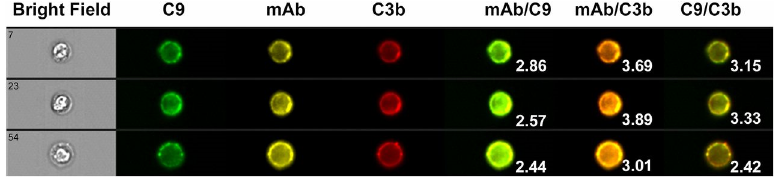
Figure 12. C3b and C9 are colocalized on B cells opsonized with mAb 7D8-Hx. C3b and C9 are colocalized on B cells with opsonizing mAb 7D8-Hx after reaction for brief periods in 50% NHS. Data were obtained based on multispectral high-resolution fluorescence imaging by flow cytometry. CLL cells were reacted with Al546 Hx-7D8 in NHS for 8 min and after two washes were probed with both FITC mAb aE11 and with Al594 3E7 (for C3b/iC3b). Images representative of triple-positive cells are shown. Bright detail similarity score (BDSS) values for the merged images of the individual cells are given. A very high degree of colocalization of Hx-7D8 with C3b is evident, and colocalization of the mAb with C9 is also observed. [20] .